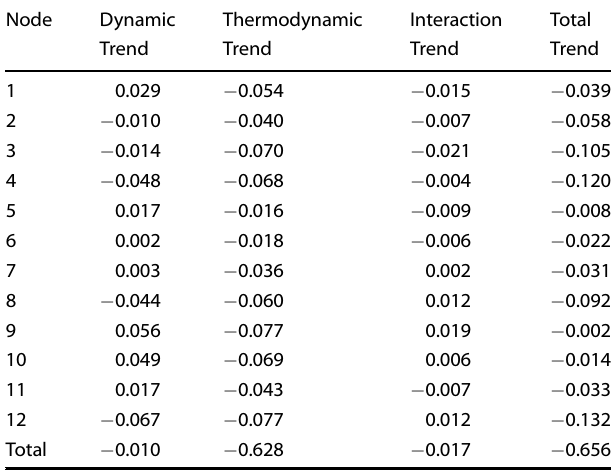
Table 1. The domain-averaged trends of the number of days with sea ice concentration ≥ 0.15 for dynamic, thermodynamic, and interaction components of each node and their total trends.